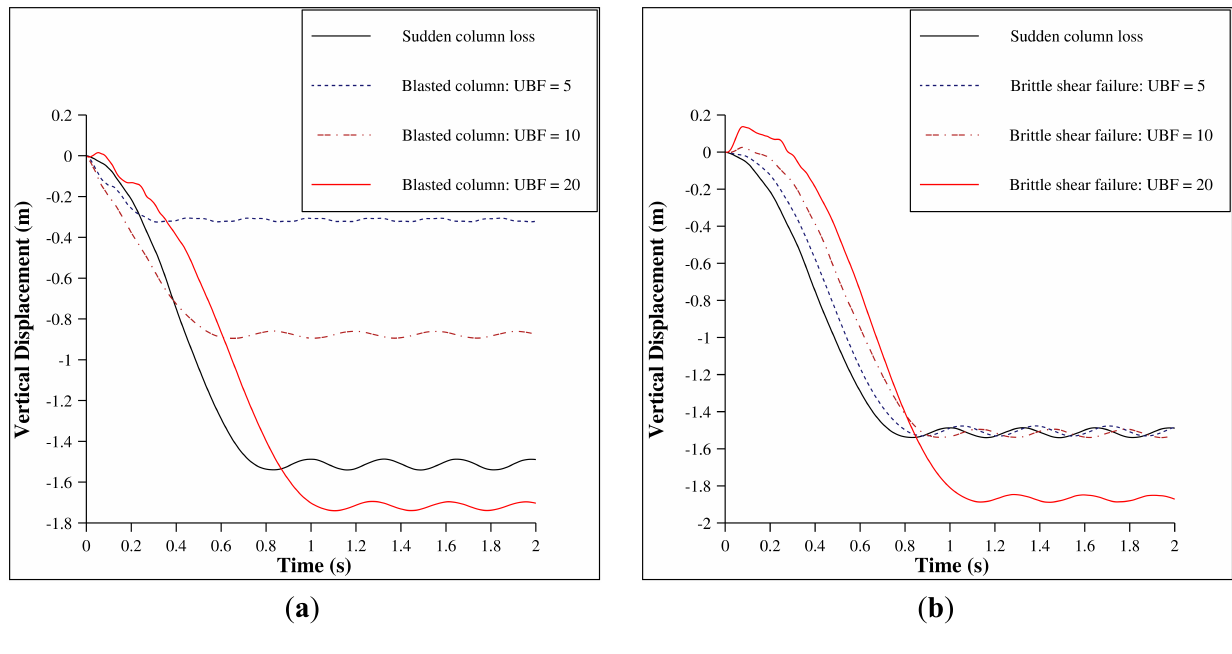
Figure 4. Comparison between sudden column loss and extreme internal